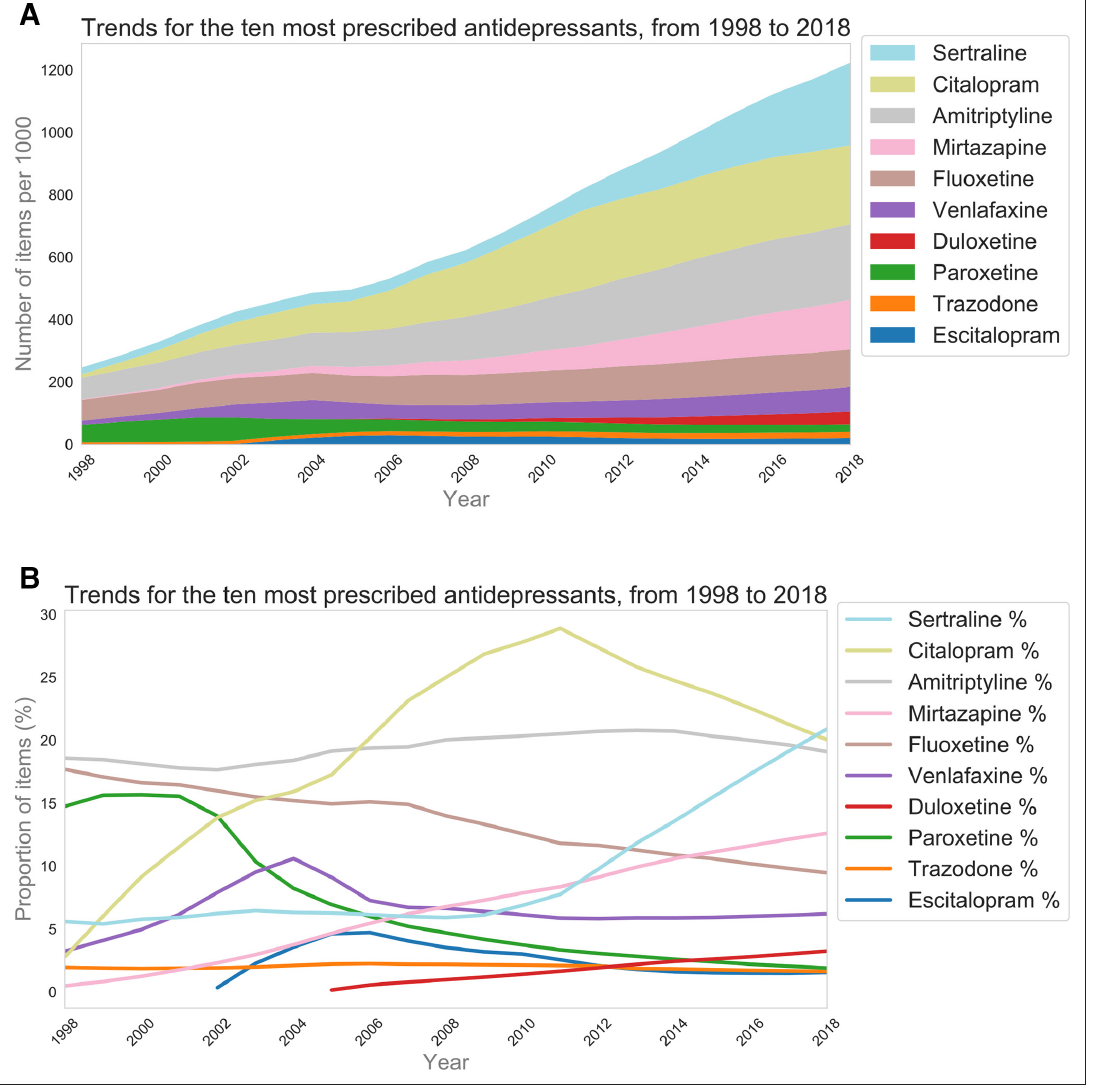
Figure 2 The population standardised numbers (A) and proportions (B) of prescribed antidepressant items for the 10 most commonly